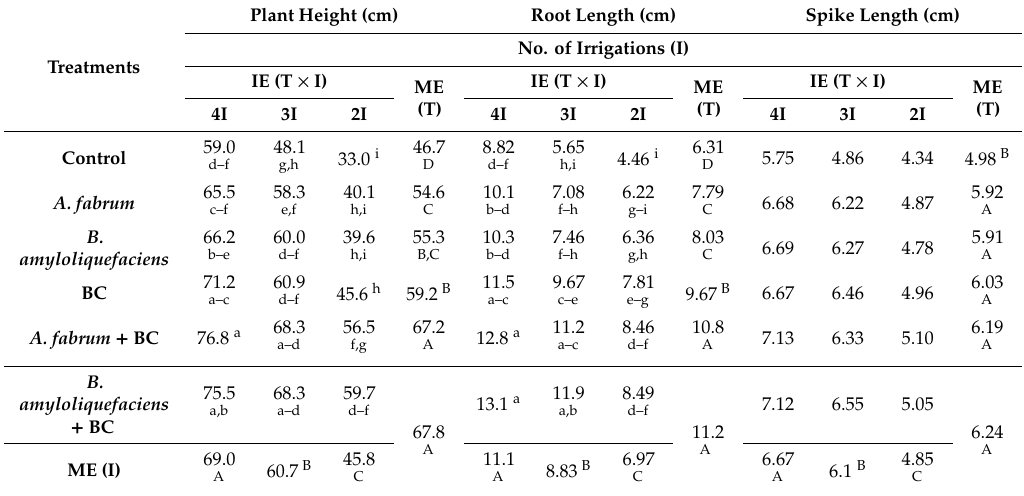
Table 2. E ff ect of Agrobacterium fabrum , Bacillus amyloliquefaciens with / without biochar (30 Mg ha − 1 ) on